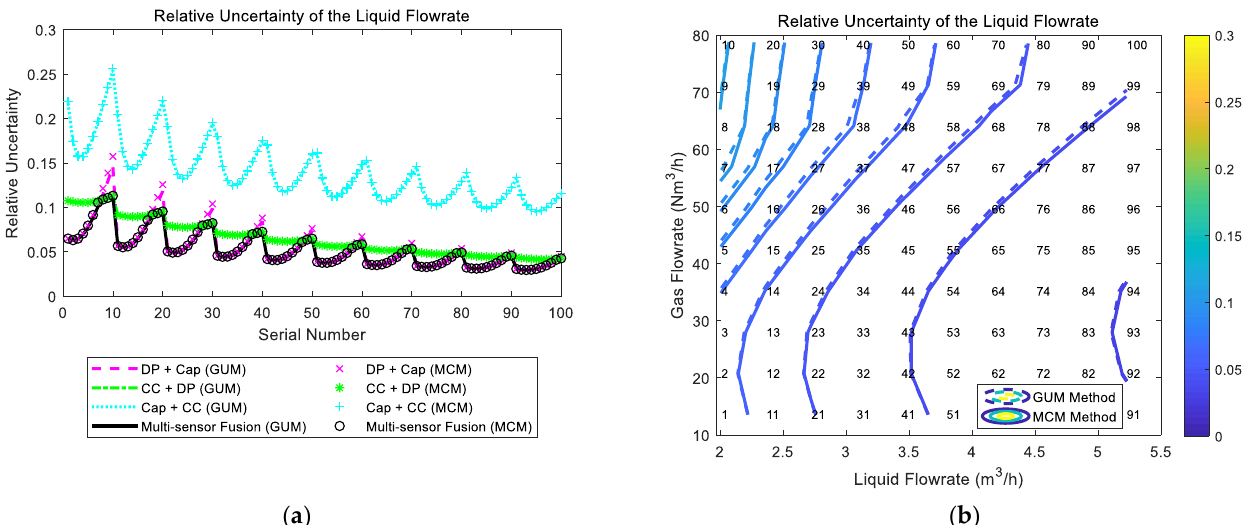
Figure 20. The composition and distribution of the relative uncertainty of the liquid flowrate of the multi-sensor fusion algorithm: ( a ) composition diagram; ( b ) distribution diagram. (Each contour line denotes an increment of uncertainty of 0.01. More information about the composition and distribution can be found in Section 2.4.1).